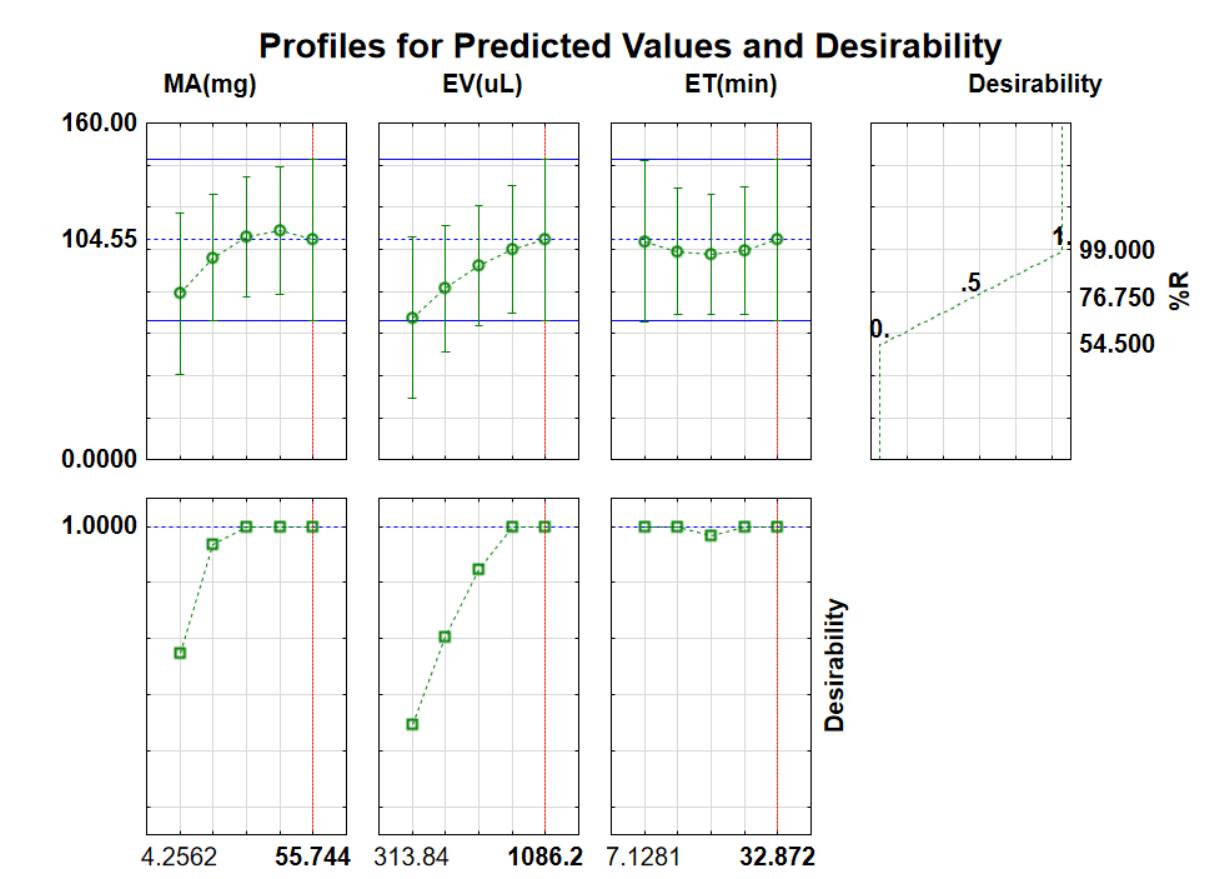
Figure 7. Profiles for desirability for the extraction of E1.